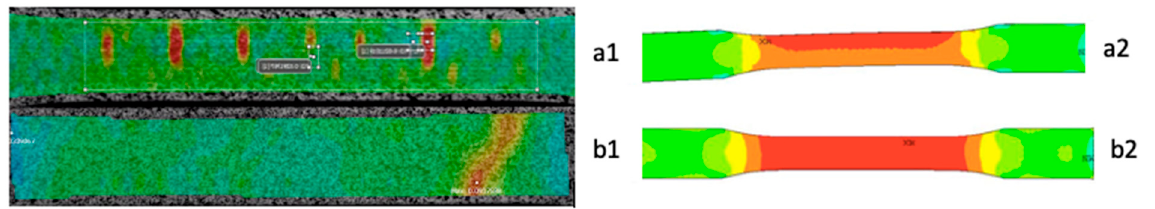
Figure 6. Cross-section of a sample made with 0.12 mm layer height and a 0/90 raster angle, contrasted with a part made with 0.21 mm layer height and a 45/45 raster angle.